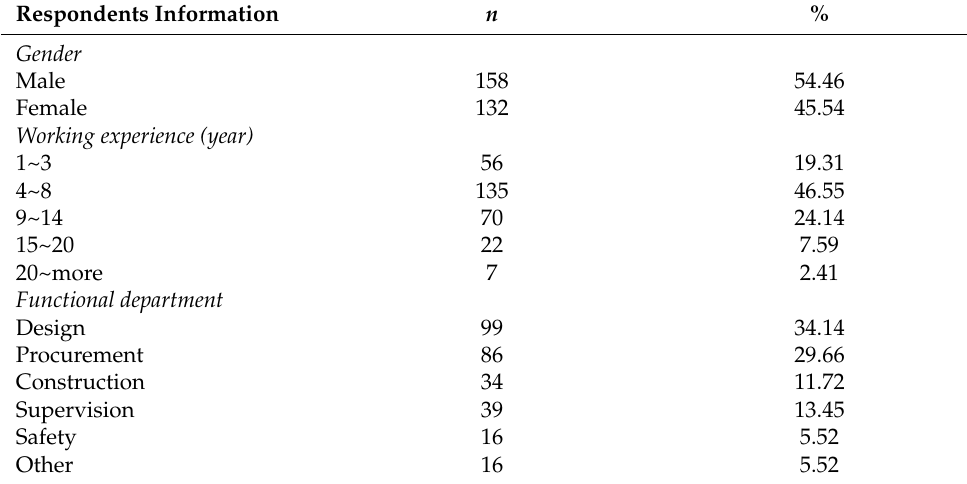
Table 1. Background information of